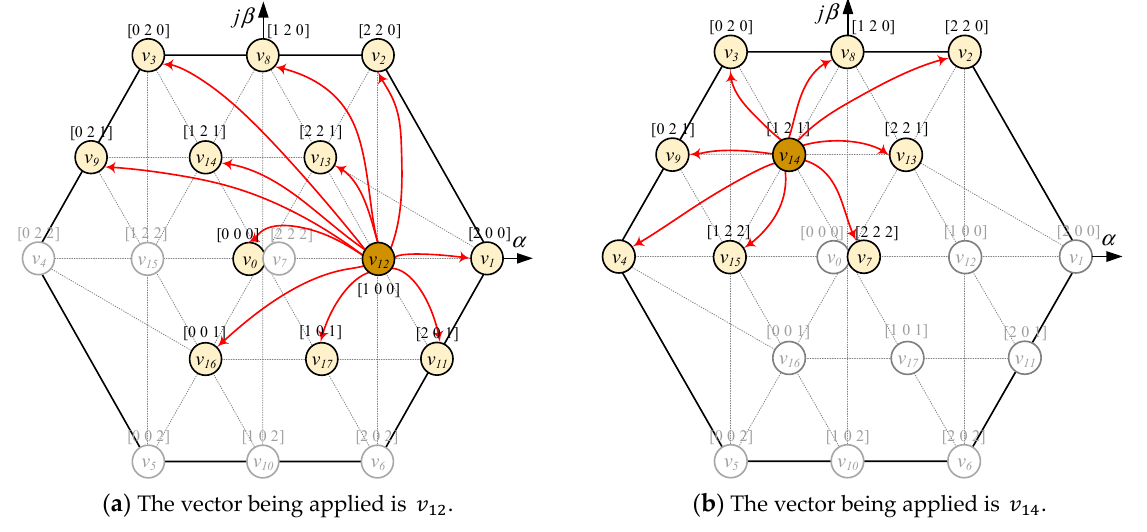
( b ) The vector being applied is 𝑣 (cid:2869)(cid:2872) . Figure 6. The strategy for selecting candidate vectors . Figure 6. The strategy for selecting candidate Table 4. The candidate vector pre-selection strategy based on the vector applied at time k. Vector The Candidate Voltage Vectors Vector The Candidate Voltage Vectors